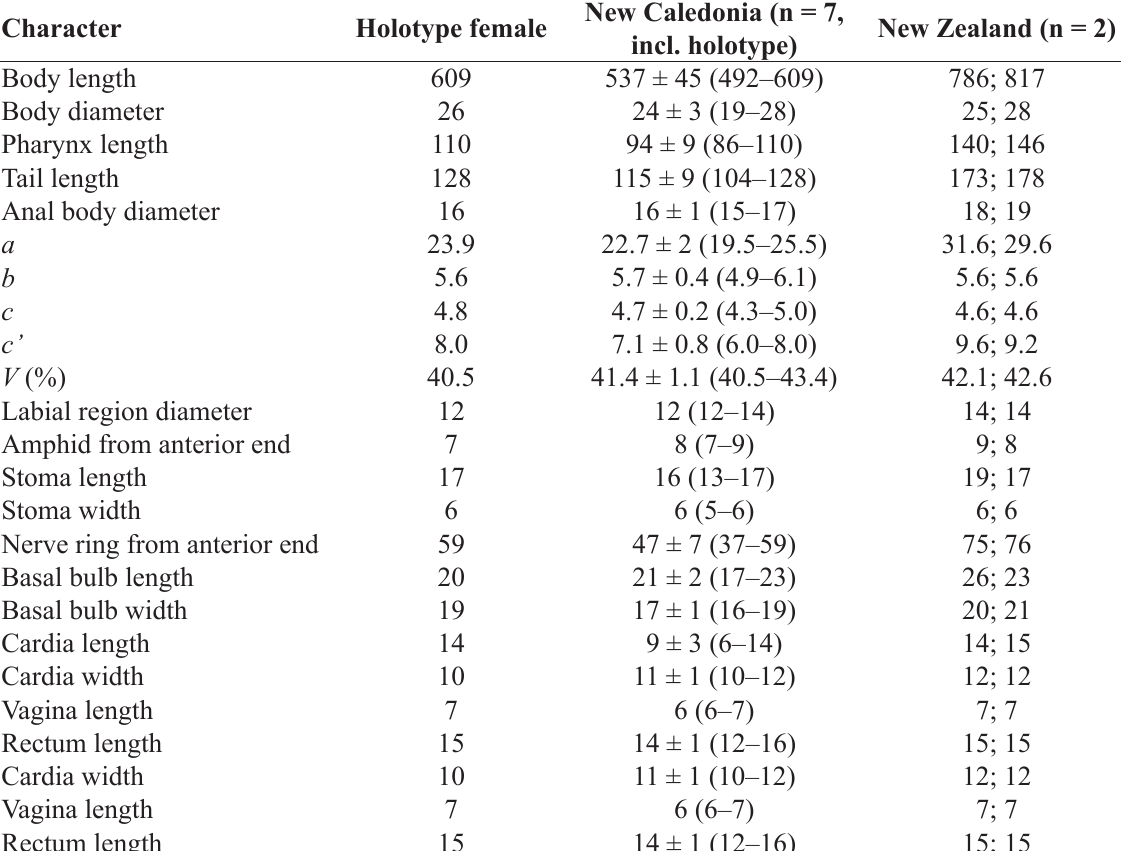
Table 3 . Morphometrics of Campydoroides manautei Holovachov gen. et sp. nov. (all measurements are in µm, except for the ratios a , b , c , c’ and V